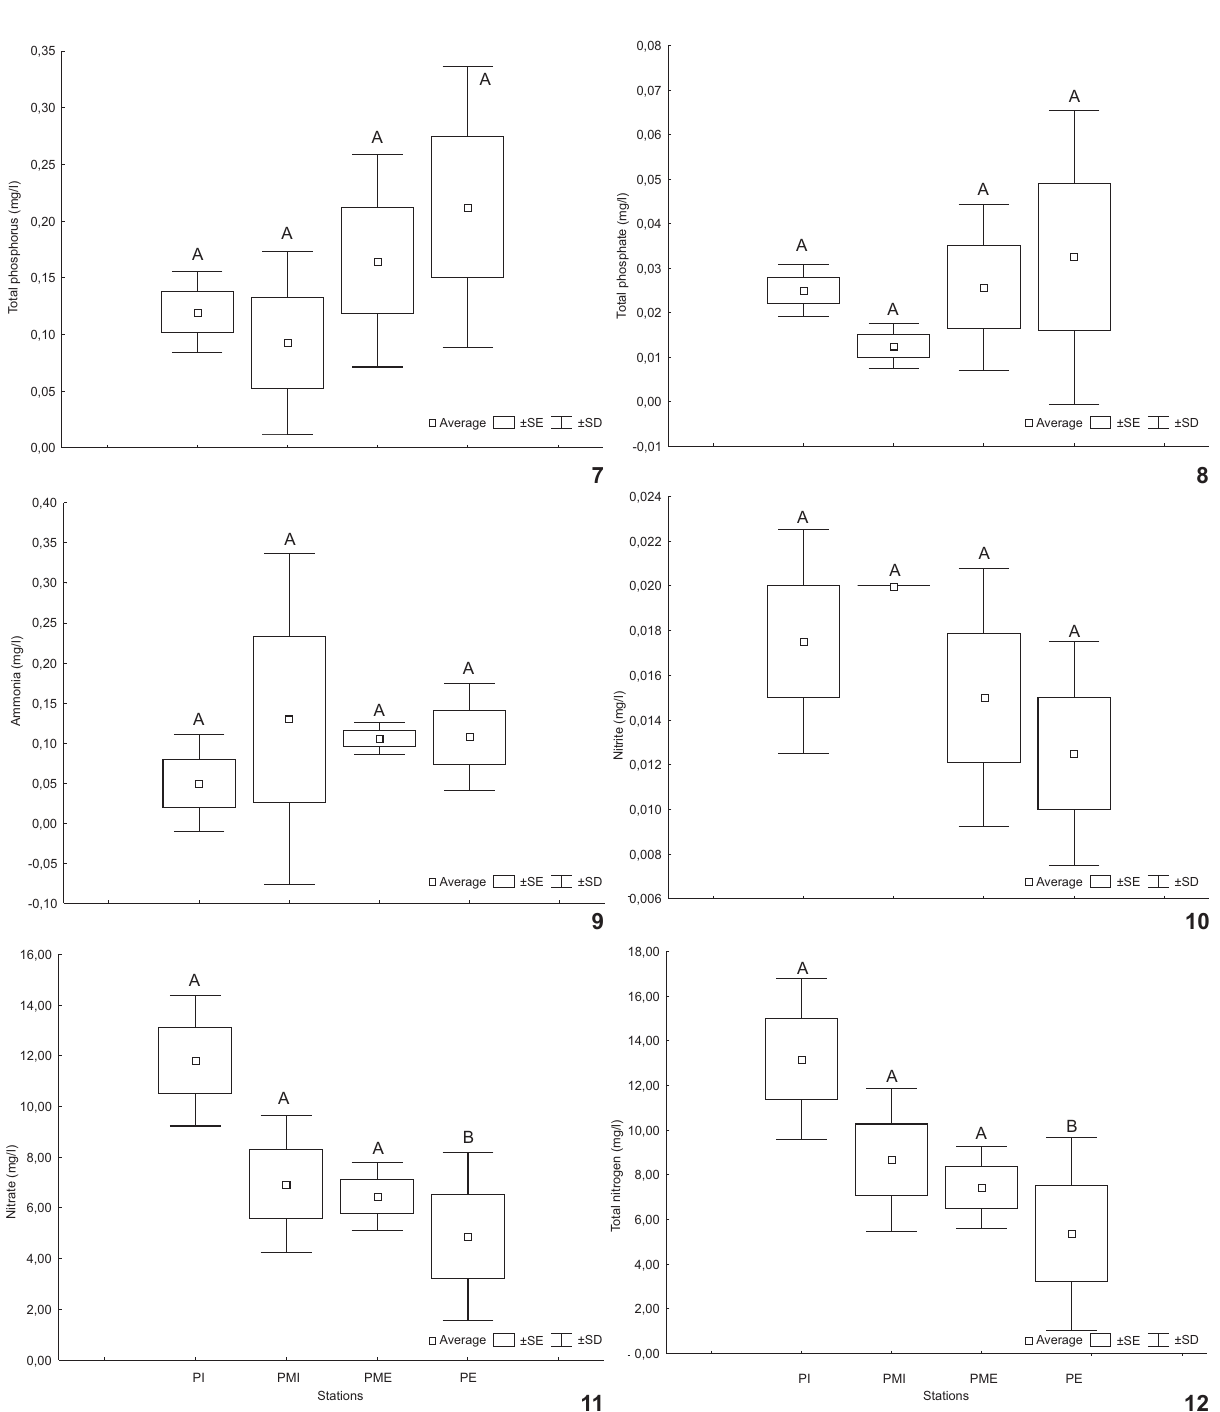
Figures 7-12. Mean values, error (EP) and standard deviation (SD) of six samples of inorganic nutrients in the four study stations PI (Internal Station), PMI (Internal Midpoint), PME (External Midpoint) and PE (External Station) along the Vitória Harbor. Letters A and B indicate the homogeneous groups (nonparametric Tukey Test, p <